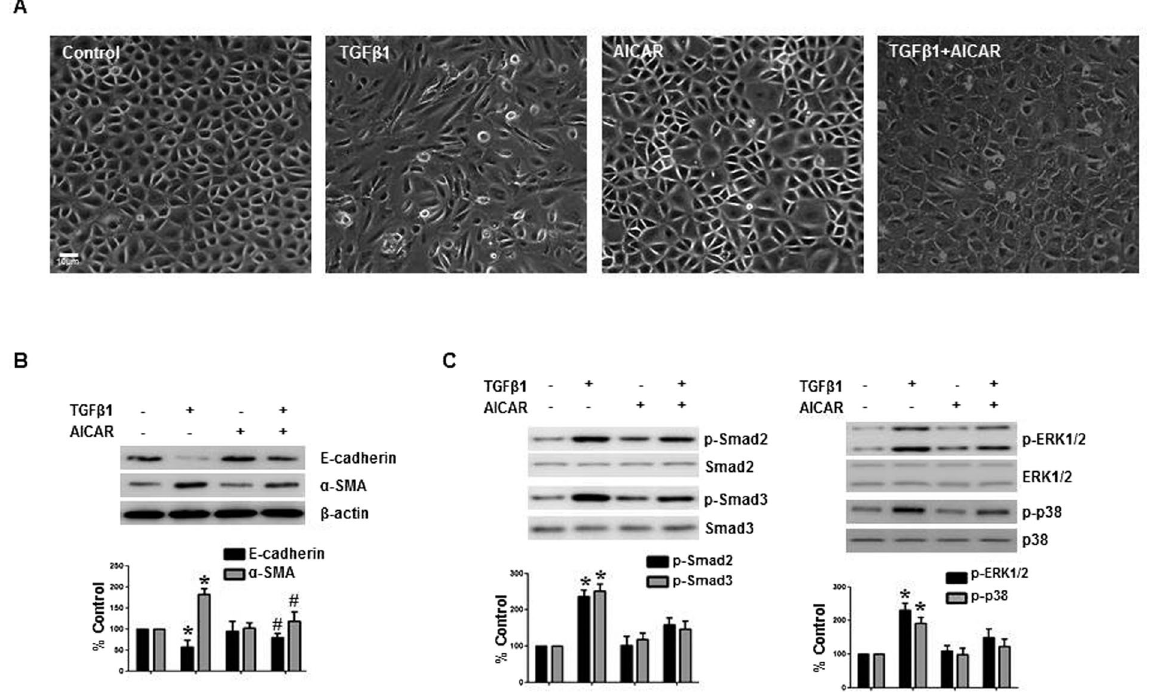
Figure 6. Effect of AMPK agonist, AICAR, on TGF- β -induced EMT and Alteration of Intracellular Signaling Pathways. AICAR (5-amino-1- β -D-ribofuranosyl-imidazole-4-carboxamide, 10 μ M) alleviates TGF- β 1- induced changes in cell morphology ( A ) and the expression of E-cadherin and α -SMA ( B ). AICAR does not block an activation of Smad2/3 pathway (30 minutes) and MAPK phosphorylation (3 hours) ( C ). Representative cell morphology ( A ) and western blotting with quantitation graph are shown ( B – D ). N = 6. * p < 0.05 vs. others,